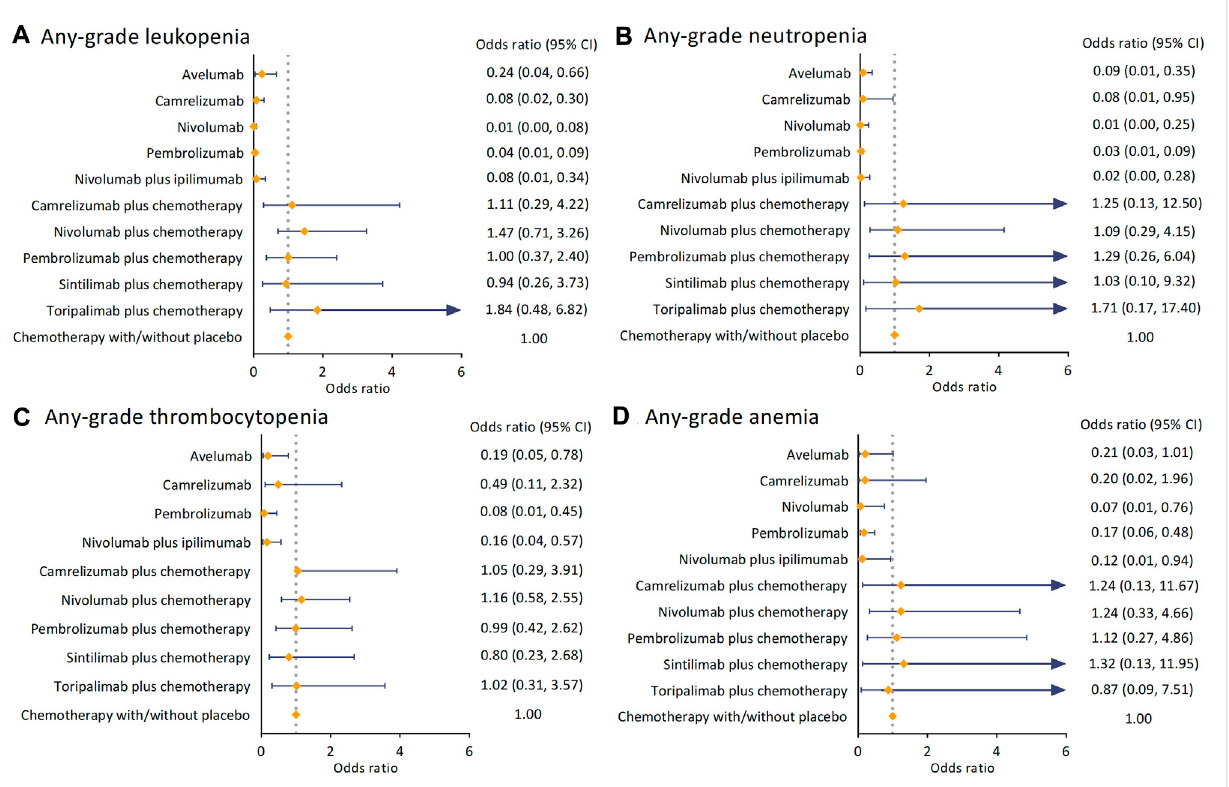
FIGURE 3 Pooledanalysisofany-gradehematologicalAEs. (A) ORswith95%CIsforany-gradeleukopenia. (B) ORswith95%CIsforany-gradeneutropenia. (C) ORs with 95% CIs for any-grade thrombocytopenia. (D) ORs with 95% CIs for any-grade anemia. Abbreviation: AE, adverse event; OR, odds ratio; CI, con fi dence